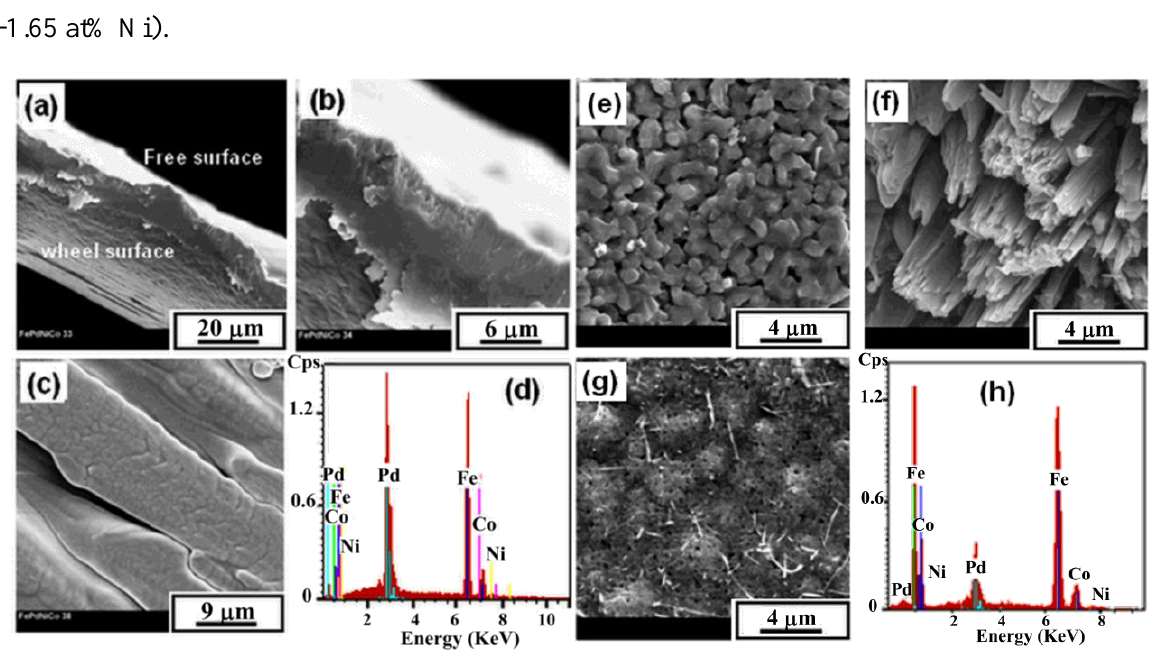
Figure 1. SEM micrographs of microstructure exhibited by as-spun and annealed Fe 68.45 Pd 28.21 Co 1.66 Ni 1.66 ribbons at 600 °C for 1 h: ( a ) typical cross section; ( b ) higher magnification of cross section; ( c ) free surface for as-spun ribbons; ( d ) EDX corresponding to the as-spun ribbons; ( e ) free surface for annealed ribbons; ( f ) View of microwires growth; ( g ) wheel surface for annealed ribbons and ( h ) EDX corresponding to the annealed